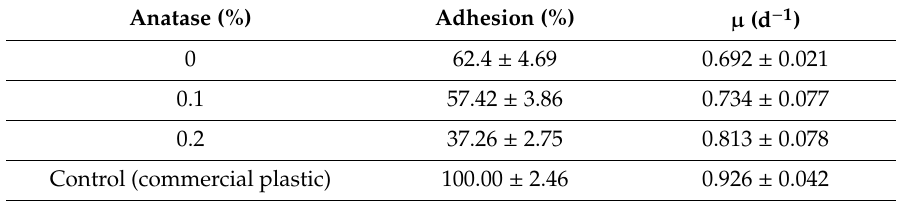
Table 3. Cell adhesion and growth ( µ ) on sca ff olds prepared with di ff erent anatase